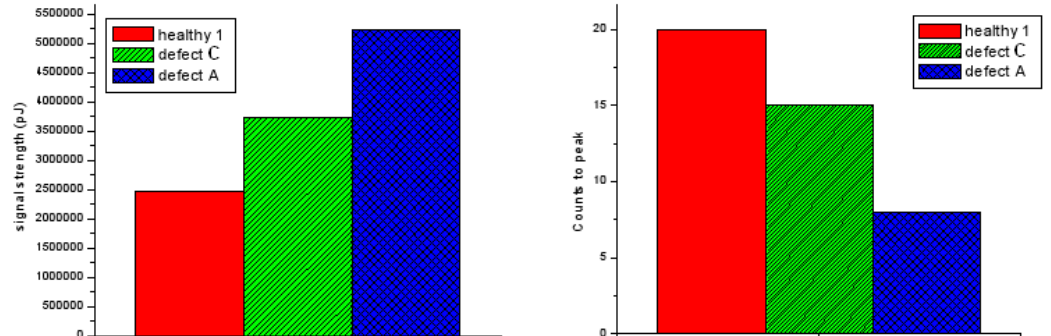
Figure 6. Defects A and C signal strength and counts-to-peak extracted from acousto-ultrasonics (AU) waveforms compared to the non-defective state.